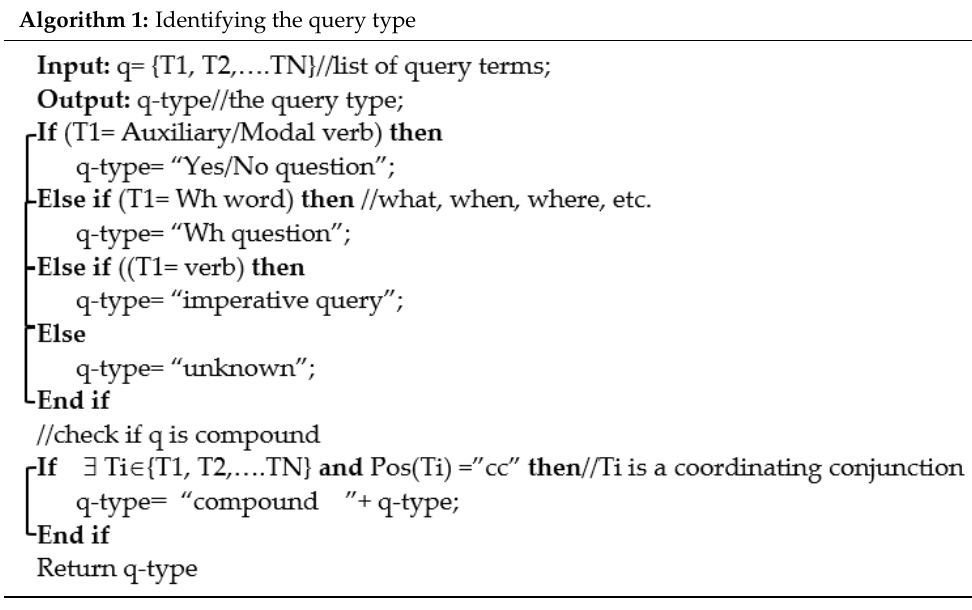
Algorithm 1: Identifying the query type